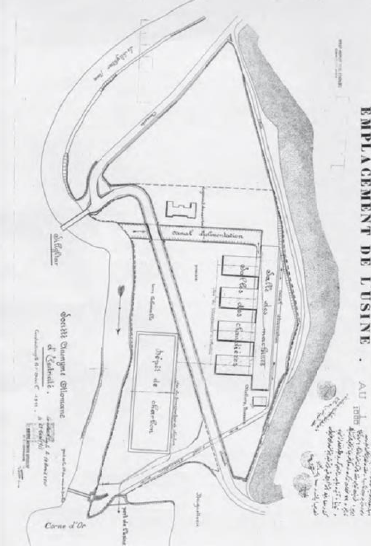
Figure 8. Silahtarağa Power Plant, site plan drawn in 1910.